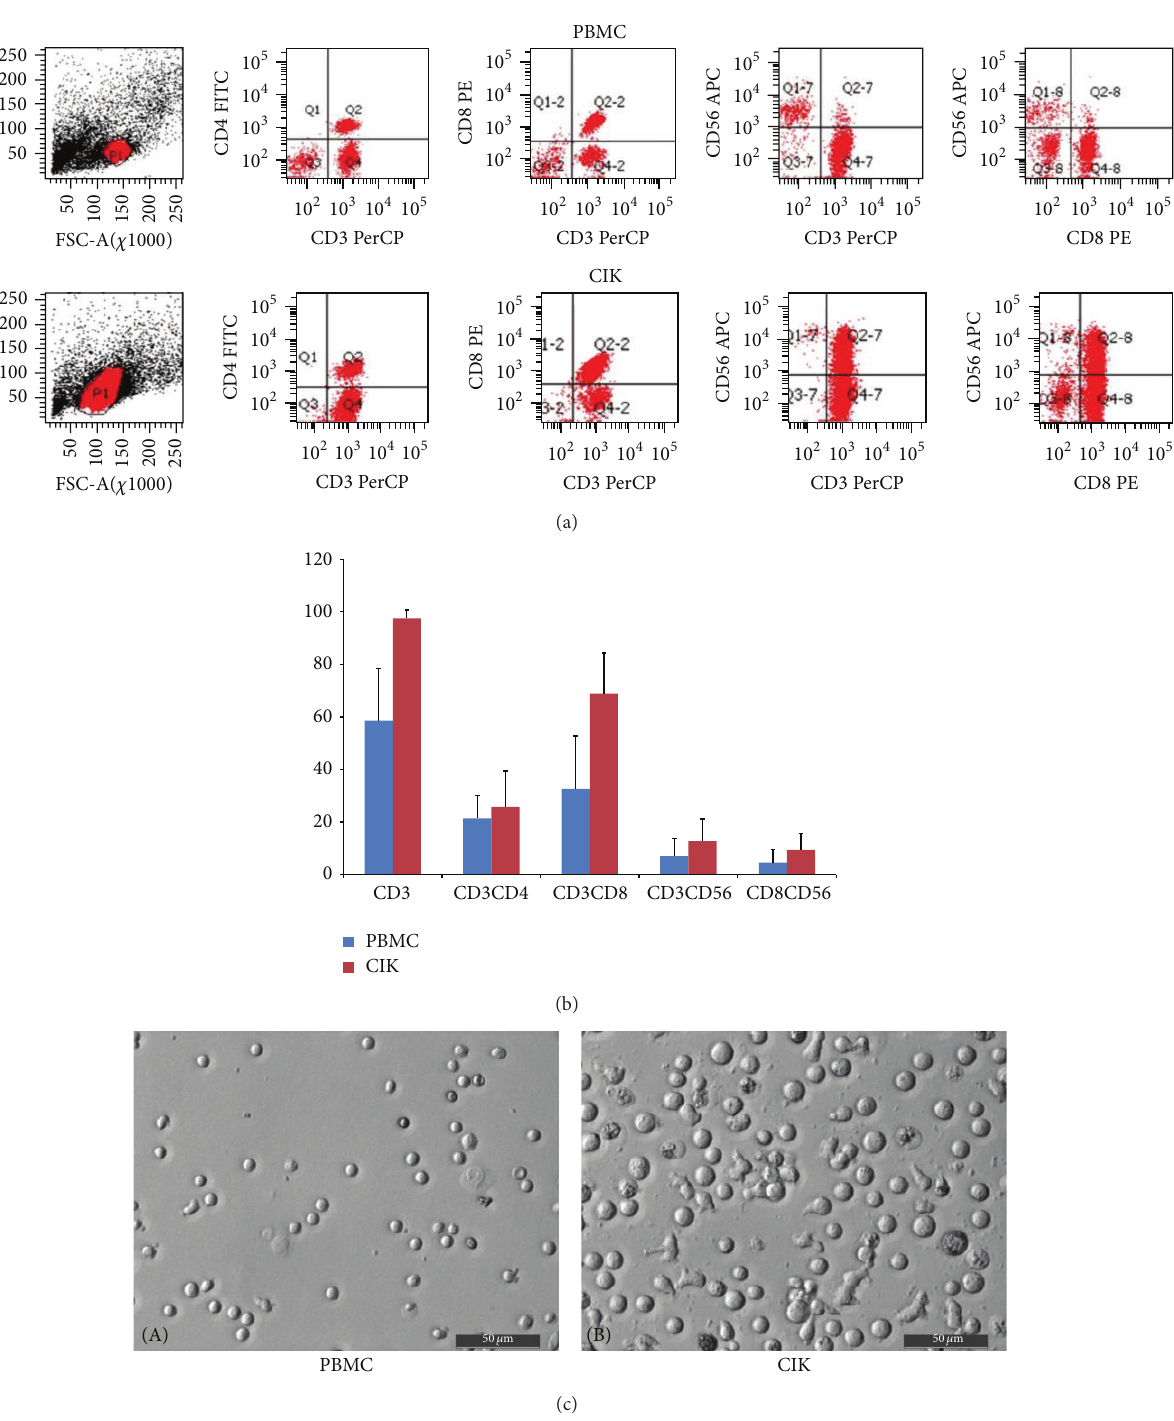
Figure 2: Phenotype analysis of cells from patients and detection of CIK cells and leukemic markers by FACS analysis. All cell samples for phenotype analysis were stained with FITC-conjugated antibodies against CD4, PE-conjugated antibodies against CD8, and APC-conjugated antibodies against CD56. (a) Typical phenotype analysis of PBMCs and CIK cells from CIK cell treatment group patient 7. (b) Comparison of the phenotype analyses of PBMCs and CIK cells. Phenotype comparisons were performed in samples from 10 patients who received CIK cell treatment, and the results were expressed as means ± SD. (c) Lymphocyte culture (PBMC and CIK). (A) PBMCs before isolation, induction and culture; some T lymphocytes can be seen in the peripheral blood. (B) After isolation, induction, and culture, lymphocytes become